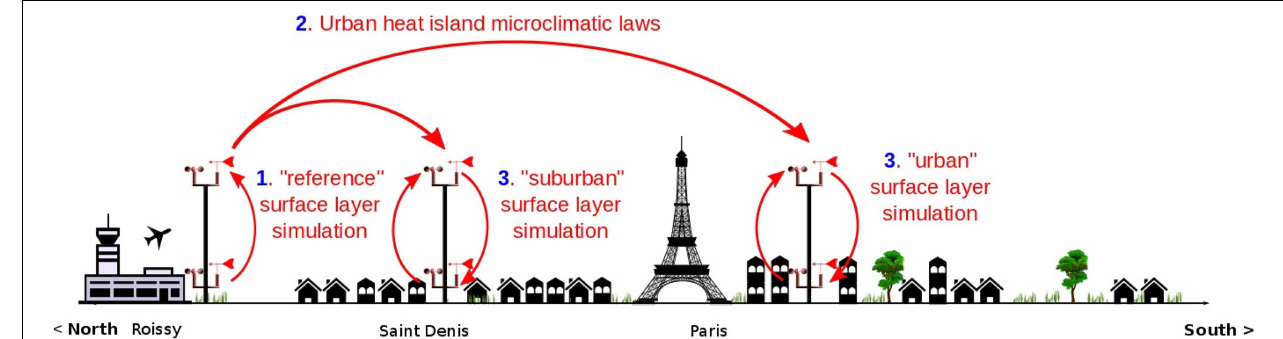
FIGURE 1 | The three steps of the spatialized urban weather generator.